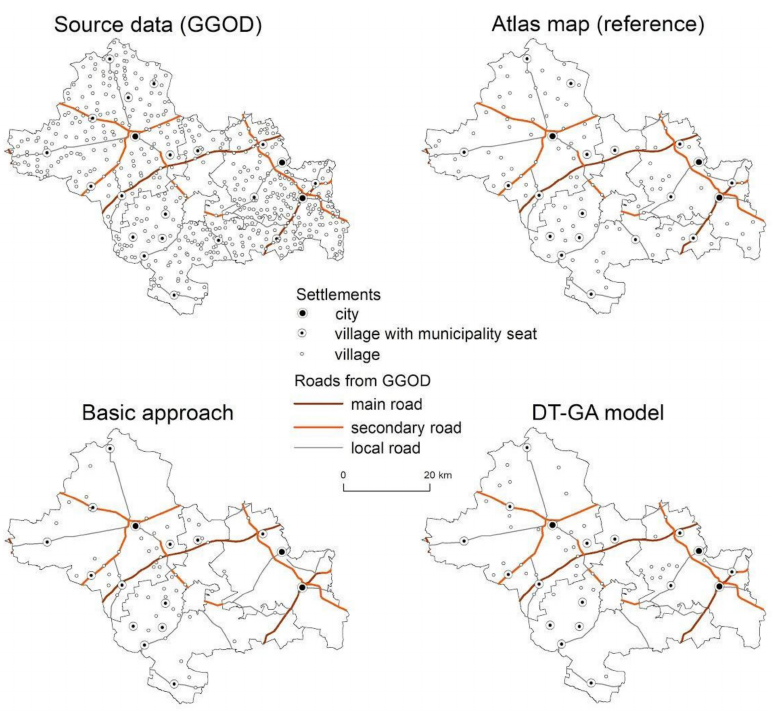
Figure 7. Maps of Łowicki, Skierniewicki and ˙Zyrardowski districts; group 3.